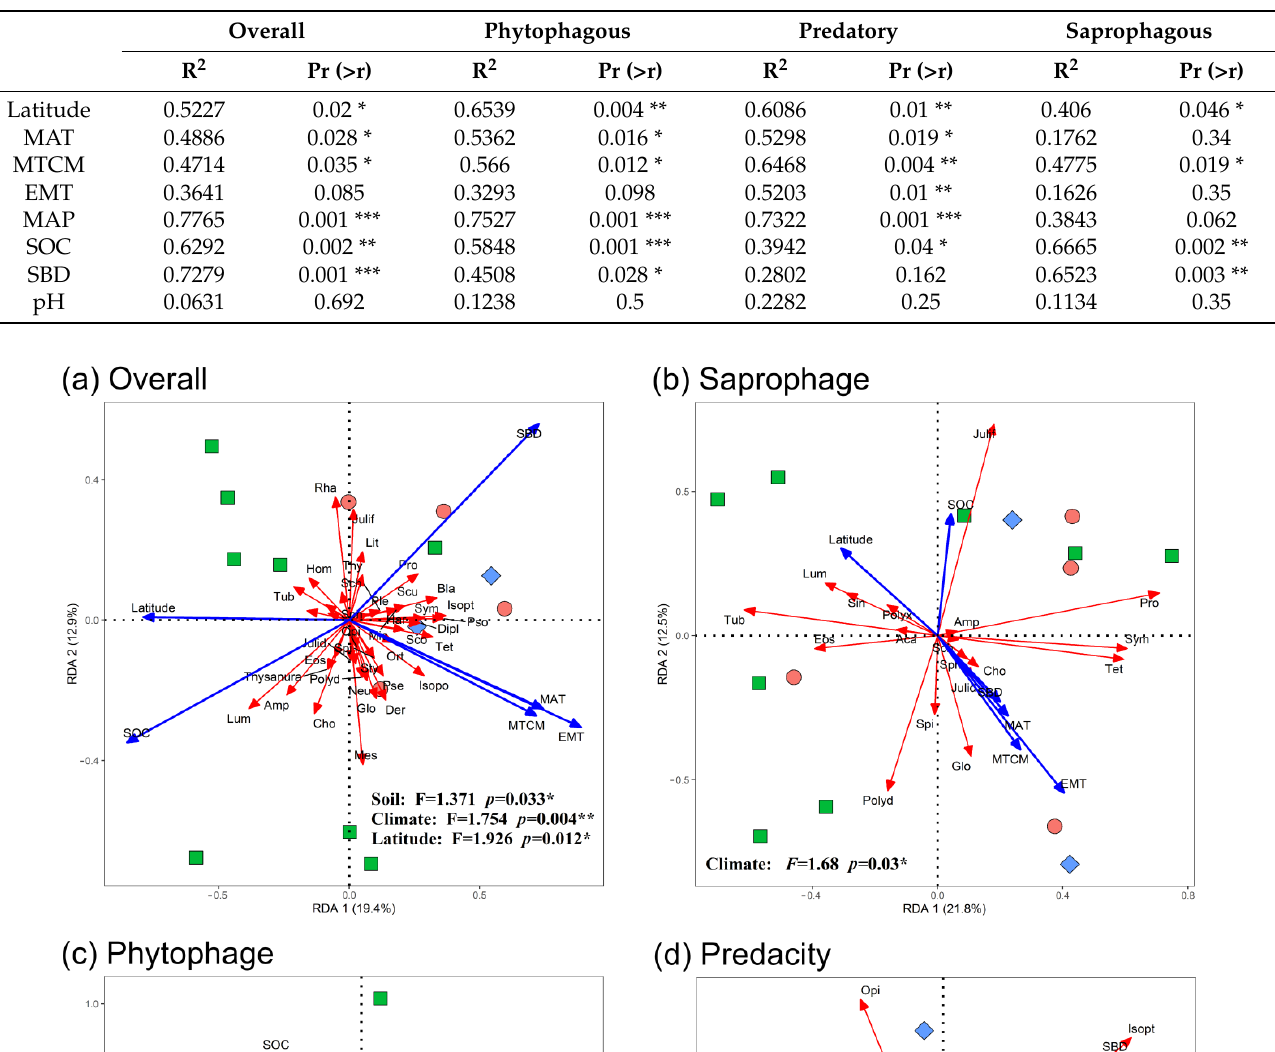
Table 5. Monte Carlo permutation test results of environmental factors in East Asia. “*”, “**” and “***” represent p ≤ 0.05, 0.01 and 0.001, respectively. (Note: MAT = mean annual temperature, MTCM = mean temperature of the coldest months, EMT = extreme minimum temperature, MAP = mean annual precipitation, SOC = soil organic carbon and SBD = soil bulk density.).